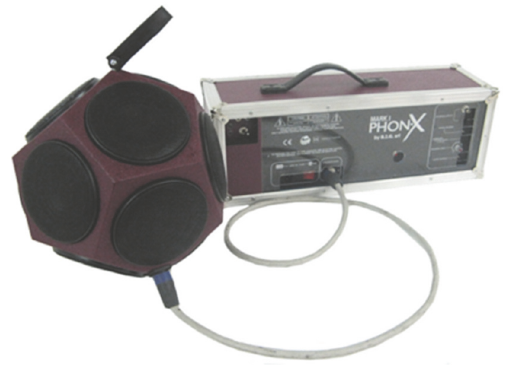
Figure 3: Dodecahedron FOUR and amplifier PHON-X Mark I.